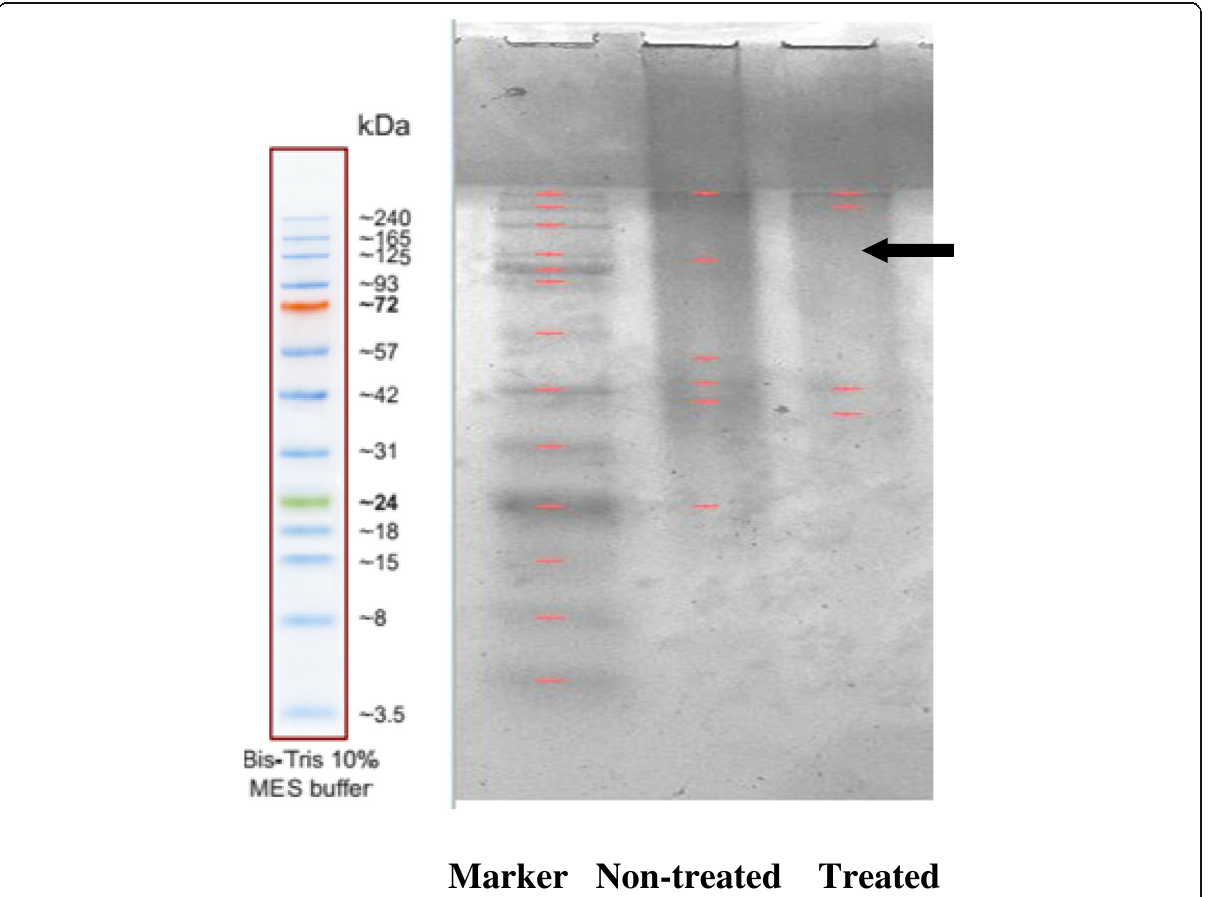
Fig. 2 Electrophoretic analysis showing molecular weight of antibacterial protein in Bacillus sphaericus -treated Culex pipiens